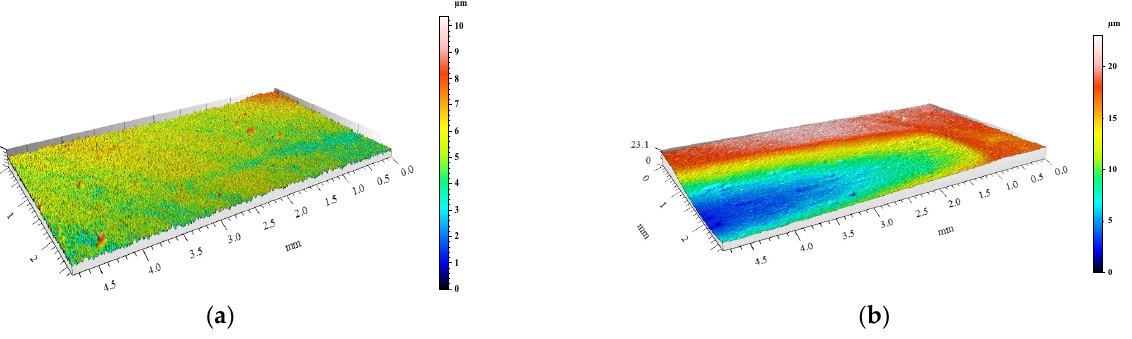
Figure 9. View of GJL cast-iron surface geometry: ( a ) before and ( b ) after dry friction test. µm